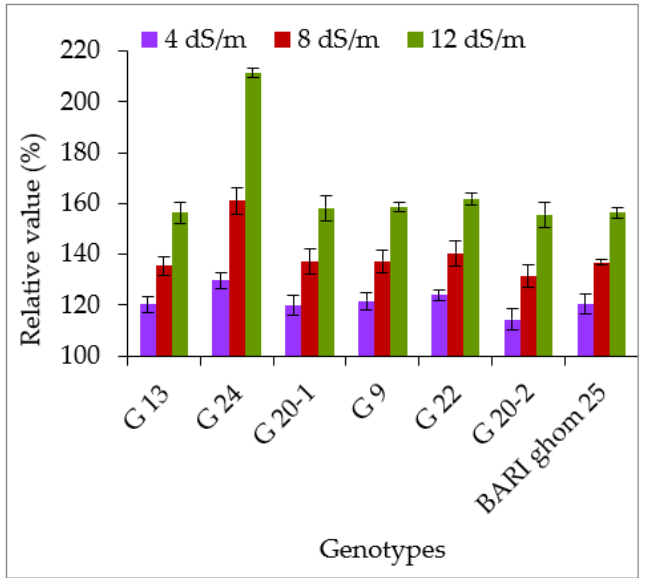
Figure 20. Relative value of melondealdehyde (MDA) accumulation in leaf of wheat genotypes under various salinity levels. The vertical bar indicates average data of five independent replicates ( n = 5). Error bars represent standard error.